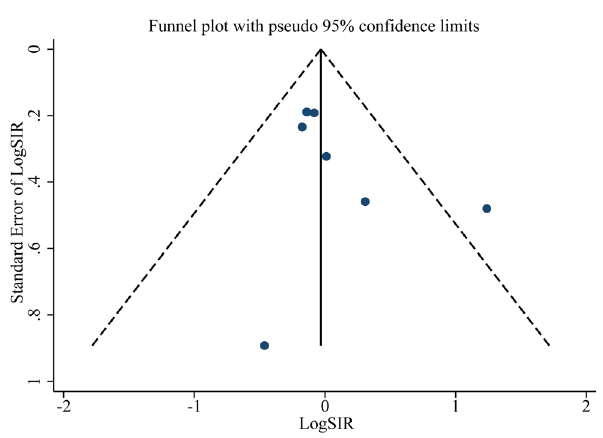
Figure 3. Funnel Plot for Publication Bias.